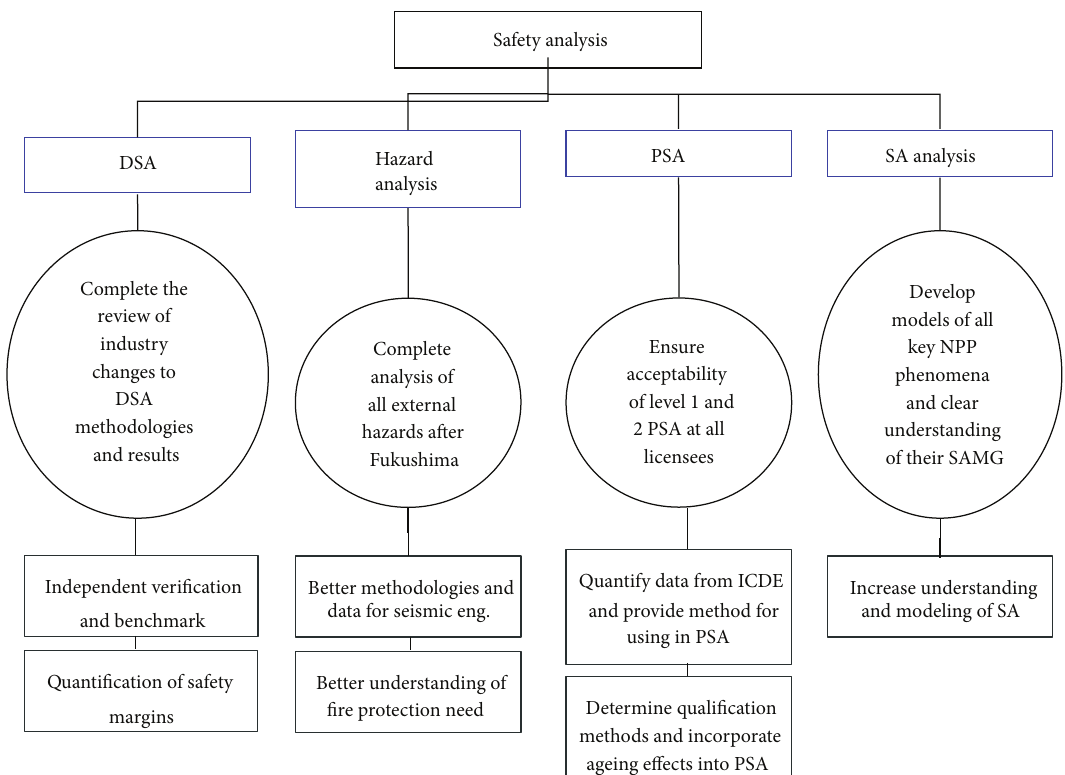
Figure 2: Illustration of CNSC research and support program in the safety analysis